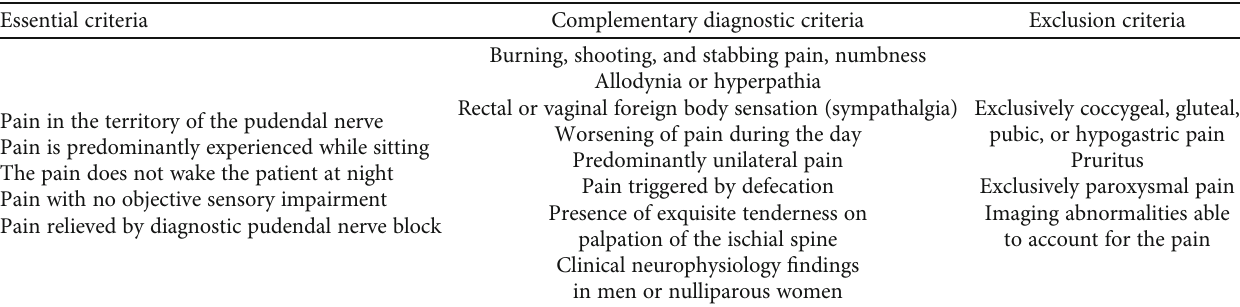
Table 1: Diagnostic criteria for pudendal neuralgia (Nantes